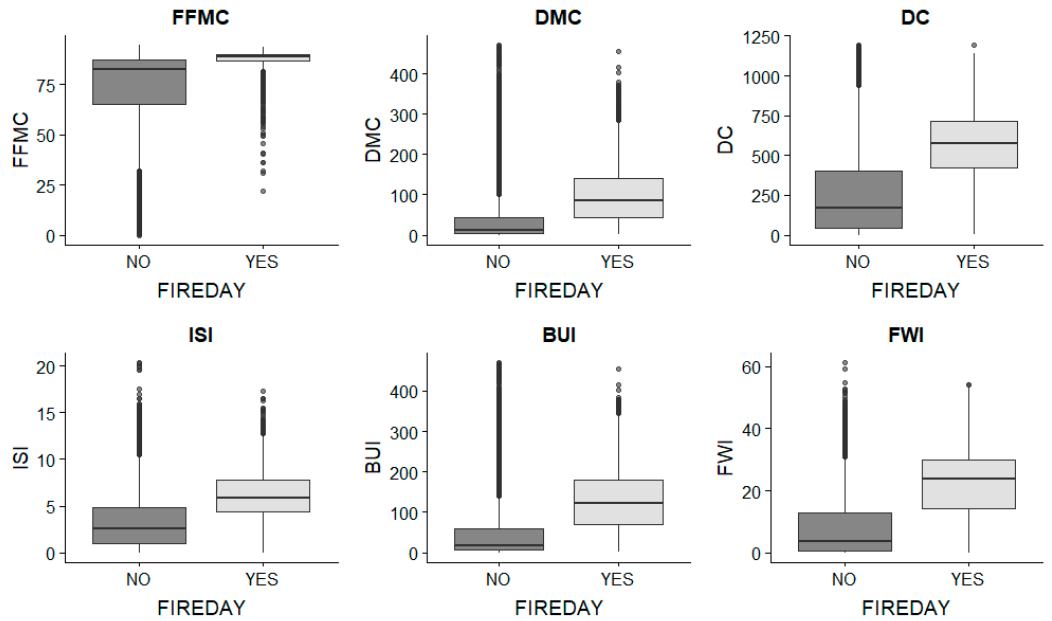
Figure A5. Comparison of Fire Weather Indexes (FWIs) as a function of fire-day status (YES with fire reported, NO without fire reported). p -values are < 0.001*** for all indexes ( t -test with resampling to have groups with the same size).